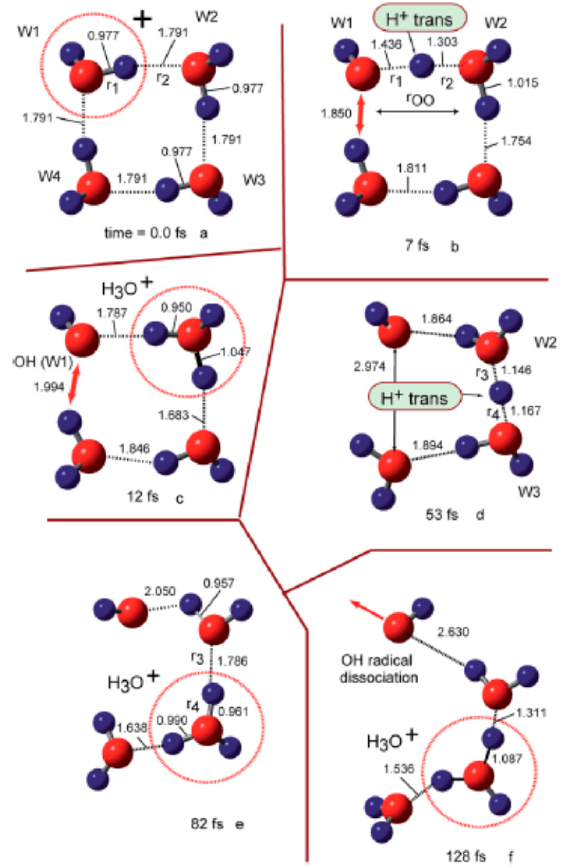
Figure 30. Snapshots of water tetramer cation (H 2 O) 4 + • after vertical ionization from optimized structure. The values are bond distance in Å. Figure adapted from [118] with permission. Copyright 2015 The Royal Society of Chemistry.